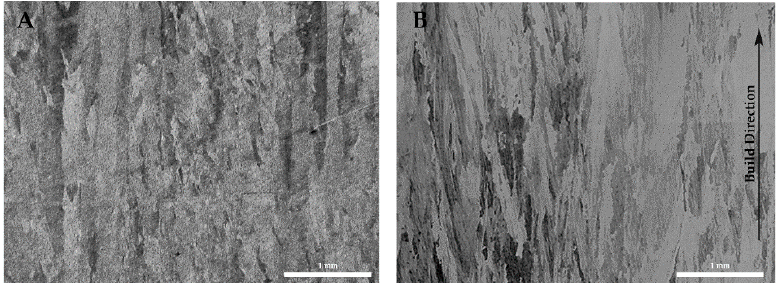
Figure 17. Oxygen and hydrogen content of precursor powders and solid copper cylinders produced with the EB-PBF of untreated and hydrogen-treated MO-Cu powder, and (inset) in-situ residual gas analysis of both EB-PBF runs, showing the layerwise outgassing of H 2 O.